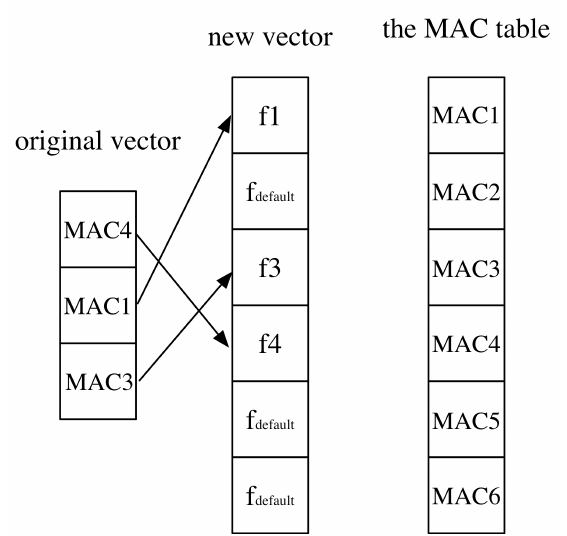
Figure 6. A simple example showing the aligning process of the RSS fingerprint. Here we assume that there are only 6 Access Points (APs). The original vector only has RSS values from MAC4, MAC1 and MAC3. The aligned new vector then has a vector length of 6 with the missing values as f default